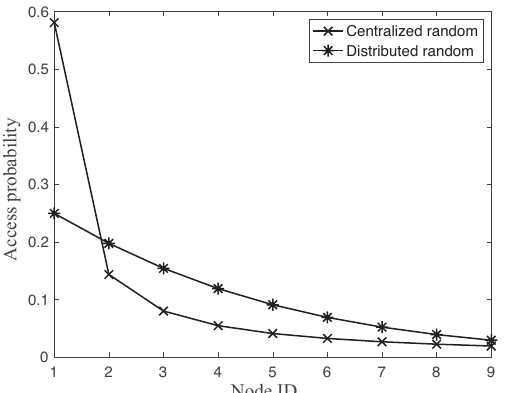
Figure 9. Access probability of each node using centralized random access and distributed random access schemes with N =